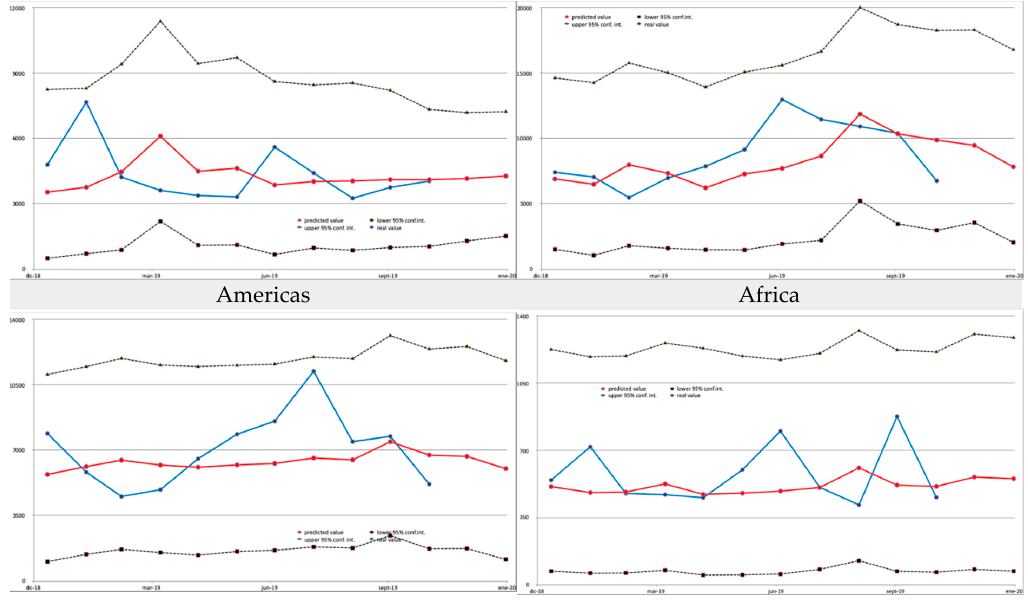
Figure A1. Predicted and real numbers of monthly aviation passenger per region.